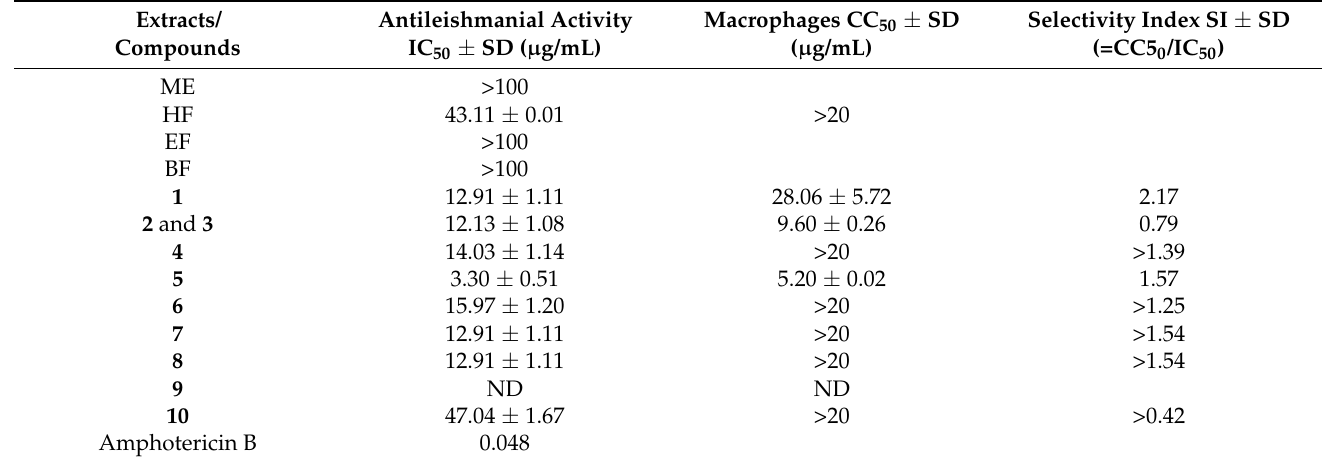
Table 3. Antileishmanial and cytotoxic activities of extract, fractions, and compounds from the stem bark of S. globulifera .